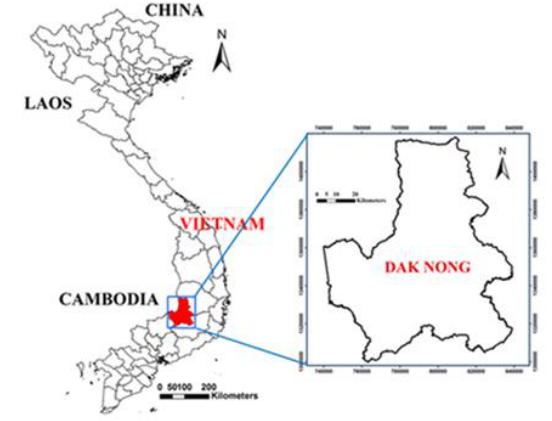
Figure 1. The study area of Dak Nong